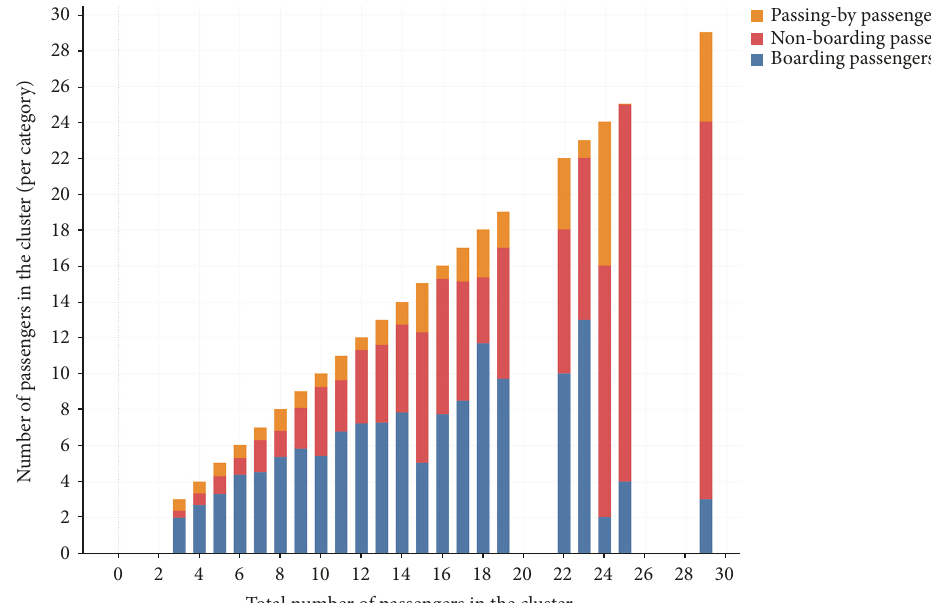
Figure 7: Distribution of passengers’ categories in the cluster accordingly to the total number of passengers in the